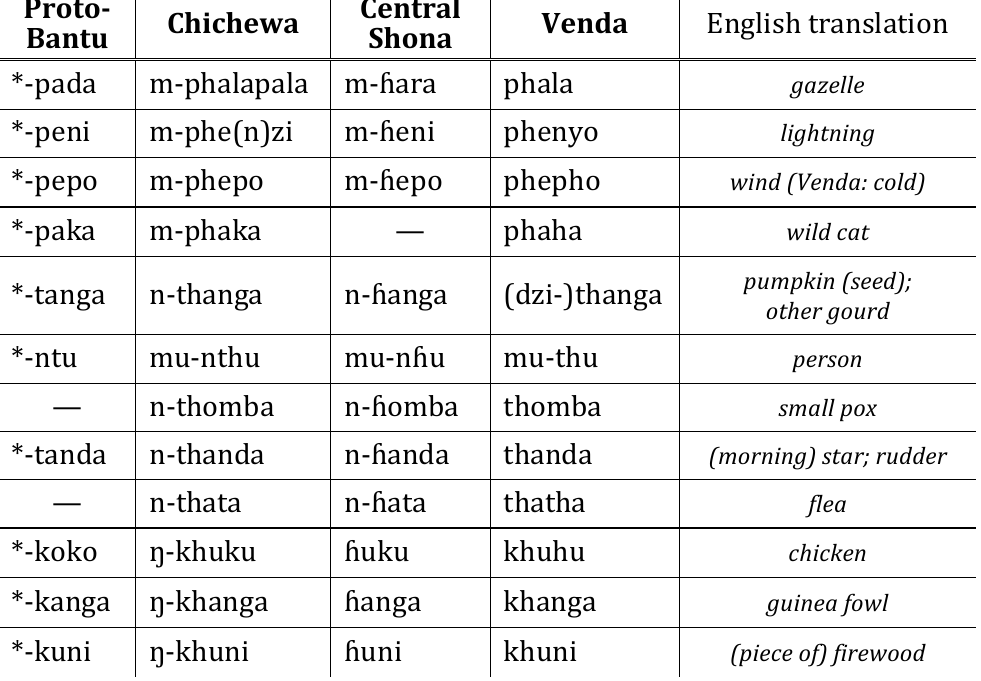
Table 1: Synchronic outcomes of Proto-Bantu *NT in words in Class 9/10